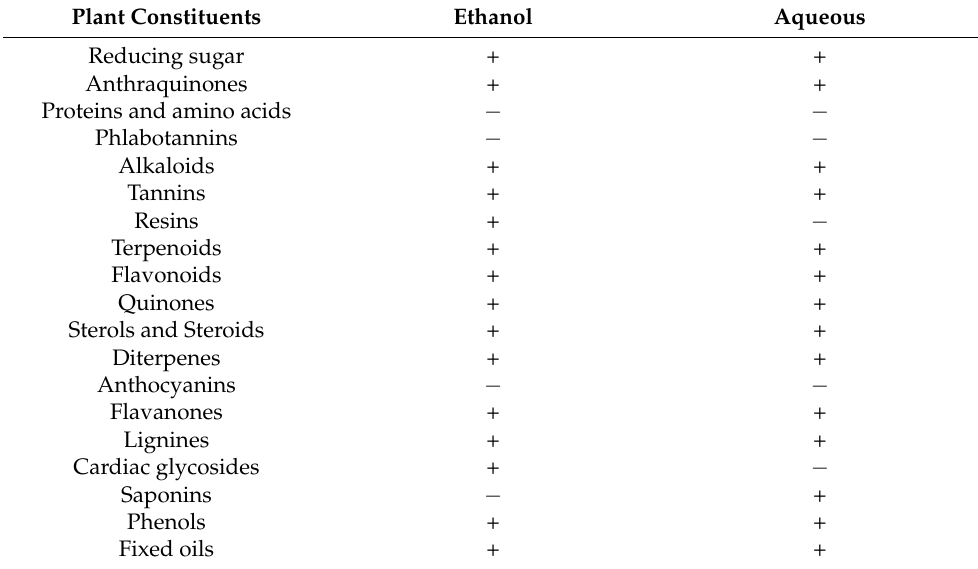
Table 2. Phytochemical screening tests of the ethanolic and aqueous extracts of Eucalyptus Camaldulensis. Plant Constituents